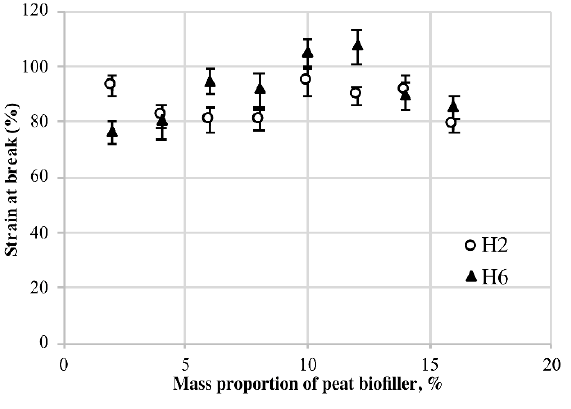
Figure 9. Strain at break as a function of the mass proportion of biomass in